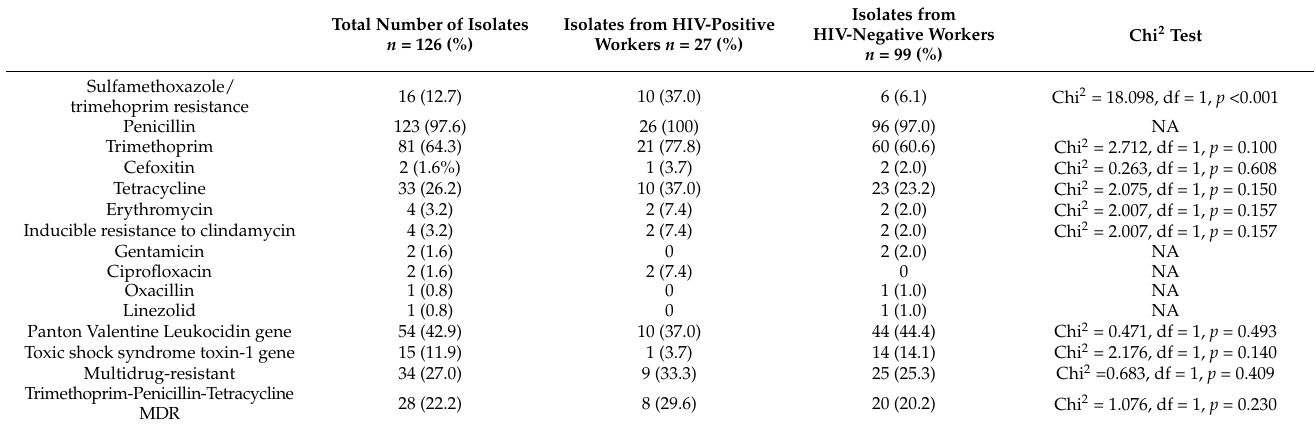
Table 2. Prevalence of antibiotic resistant Staph. aureus carriage among HIV-positive and HIV-negative abattoir workers in Busia